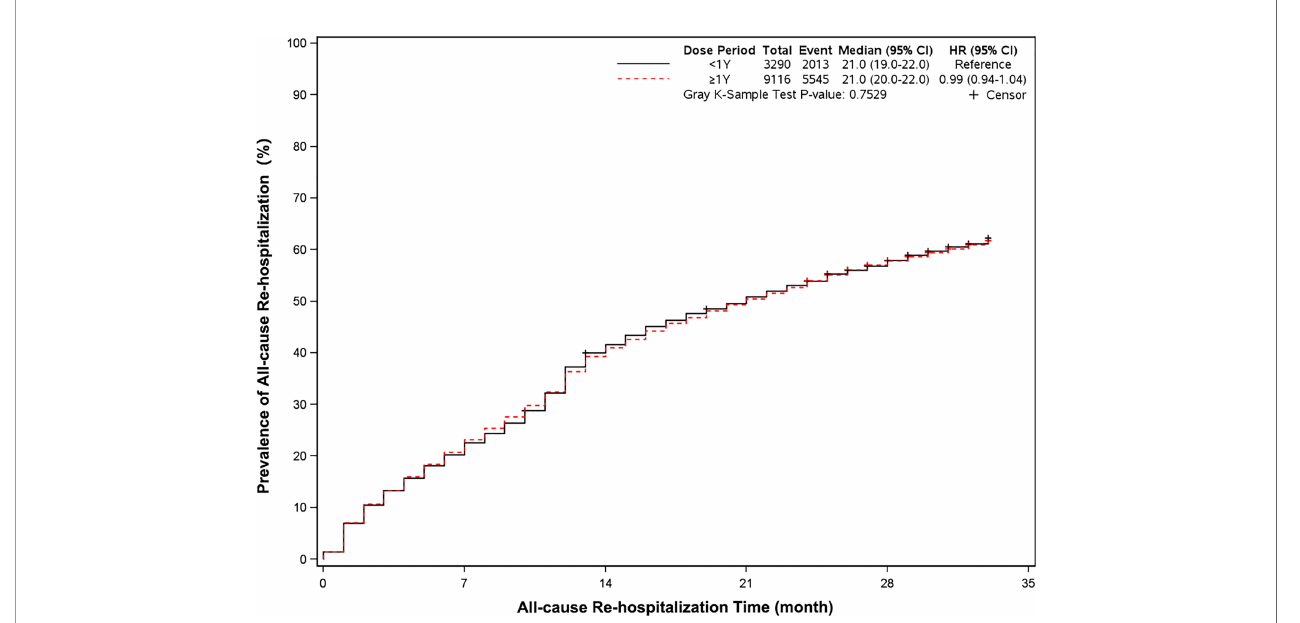
FIGURE 4 | Prevalence of all-cause rehospitalization in two groups. Blackline: patients took clopidogrel continuously 1 year; Red line: patients took clopidogrel continuously ≥ 1 year.